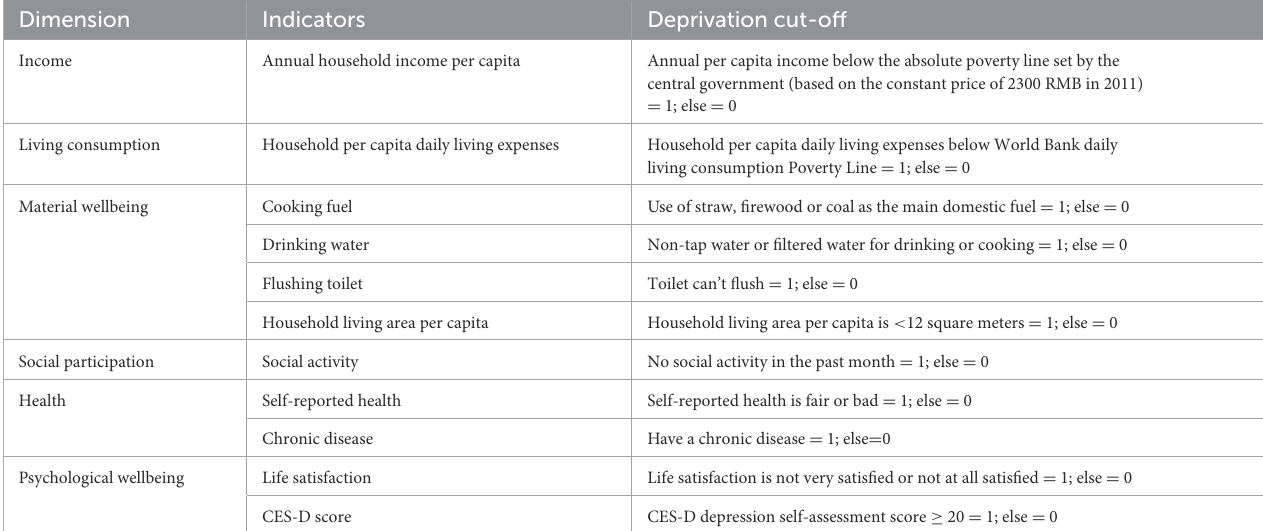
TABLE 1 Dimensions of poverty and indicators of deprivation. Dimension